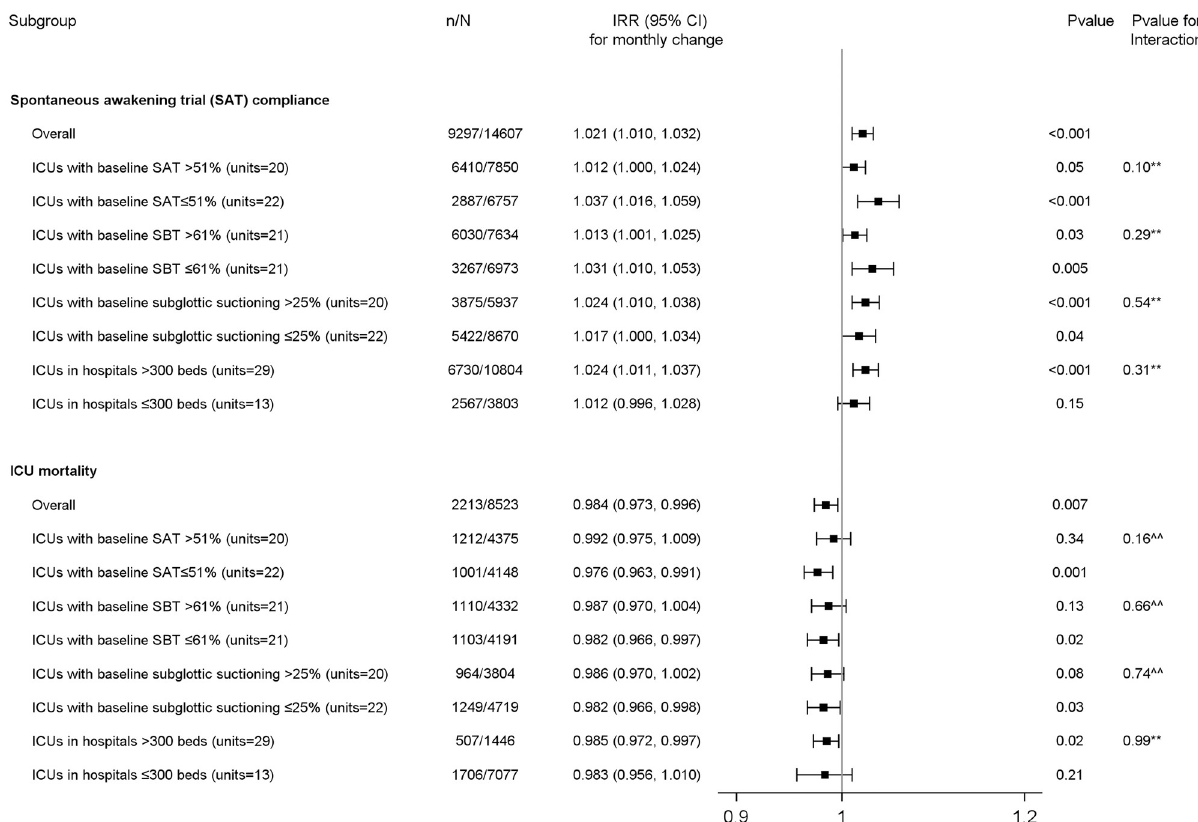
Fig 2. Forest plots for the change in spontaneous awakening trial (SAT) compliance and ICU mortality in different subgroups. The p-value for interaction is shown. Additional subgroup analyses are provided in supplement for subglottic suctioning, spontaneous breathing trial (SBT) and ventilator associated events (VAEs). Footnotes: �� The random effect Poisson regression was used to estimate incidence rate ratio after incorporating ICU unit and hospital as random effects.^^ The random effect negative binomial regression was used to estimate incidence rate ratio after incorporating ICU unit and hospital as random effects. IRR: Incidence rate ratio, CI: Confidence